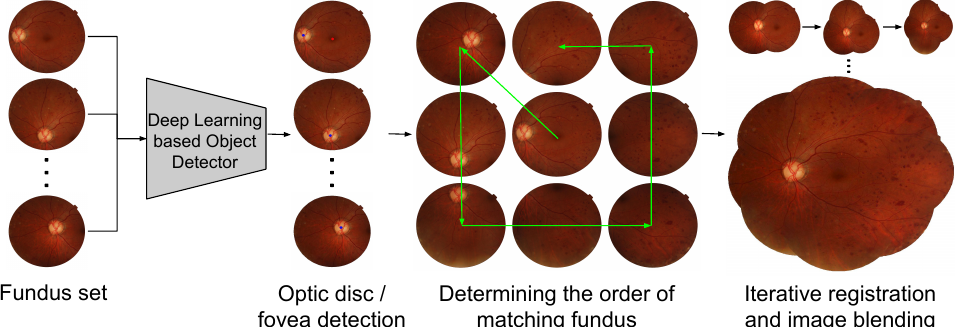
Figure 1. Overview of the proposed framework for constructing retinal fundus photomontages. Through deep learning based object detection, we are able to apply prior knowledge of the fovea and optic disc to determine the optimal order in which to integrate the images into the montage. Deep learning is also leveraged to reduce errors in